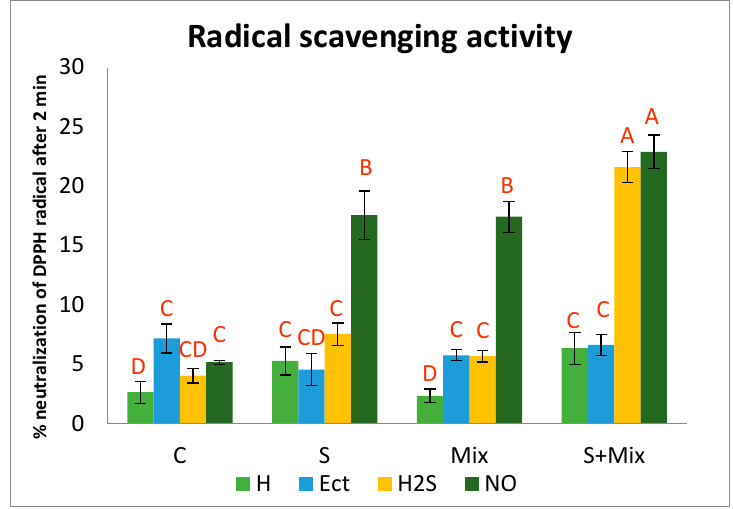
Figure 4. Radical scavenging activity of non-enzymatic antioxidants in Lobularia maritima shoots subjected to priming prior to stress exposure. Upper case letters indicate statistical significance of means acc. two-way ANOVA. Applied primers: H—water (hydropriming), Ect—ectoine, H2S—hydrogen sulfide donor GYY4137, NO—nitric oxide donor sodium nitroprusside. Treatments: C—control; S—low salinity (20 mM NaCl); Mix—metals: 0.7 mM ZnSO 4 , 16 µ M CdCl 2 , 3 µ M PbCl 2